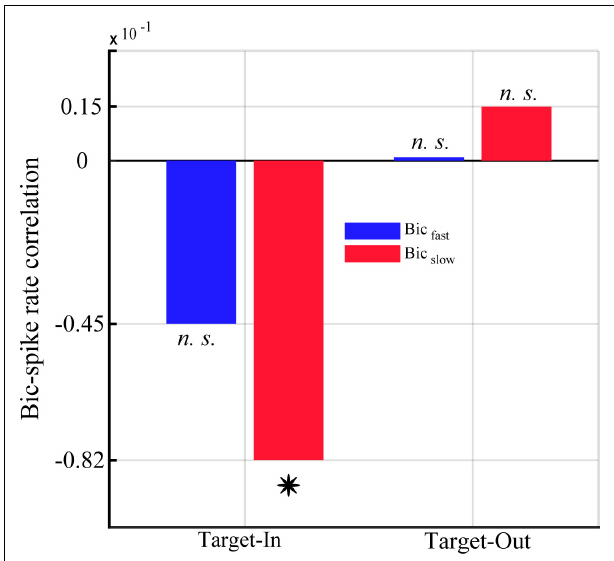
FIGURE 8 | Correlation between the single-unit spike rate and the QPC of characteristic bifrequencies in Bic fast and Bic slow groups for the Target-In and the Target-Out condition. Y -axis represents the strength of correlation between the QPC and the spike rate using Spearman’s correlation method. The star shows a significant correlation in Bic slow groups at the Target-In condition ( p < 0.002, Spearman